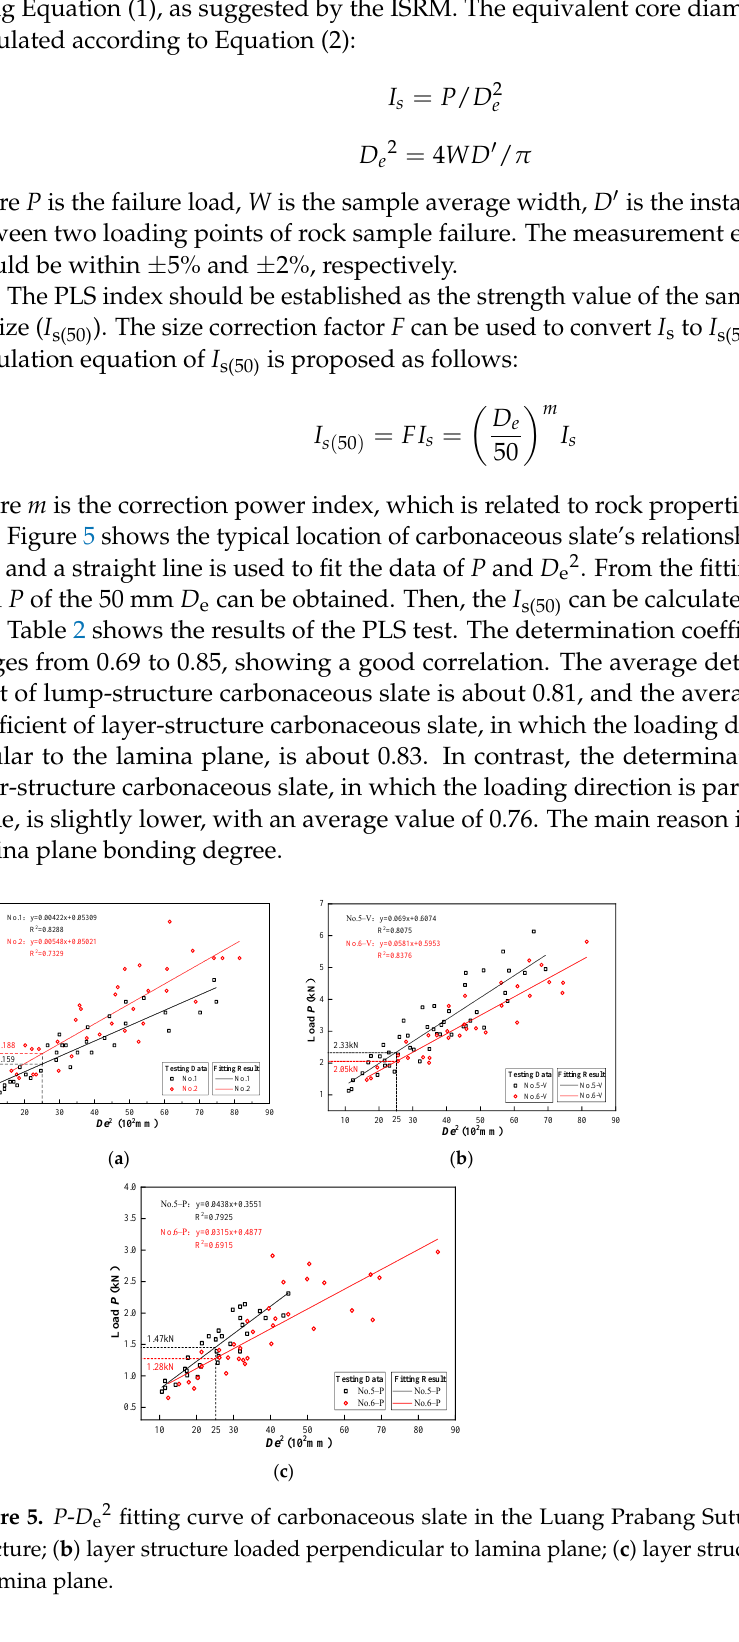
Figure 4. Carbonaceous slate UCS test samples: ( a ) UCS test sample loading direction; ( b ) cubic samples; ( c ) cylindrical samples. Note: d : Side length of cubic sample; w : Diameter of cylindrical sample; h : Height of cylindrical sample.